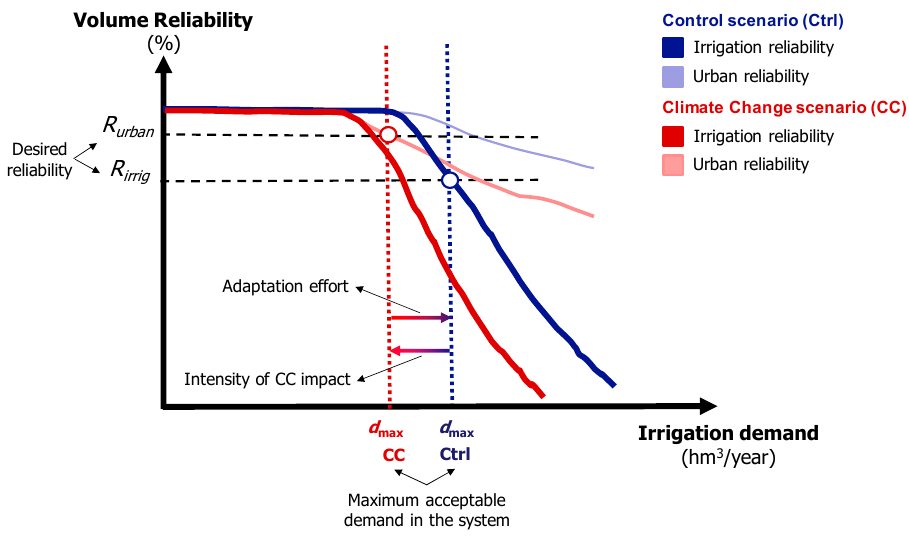
Figure 3. Methodological approach.